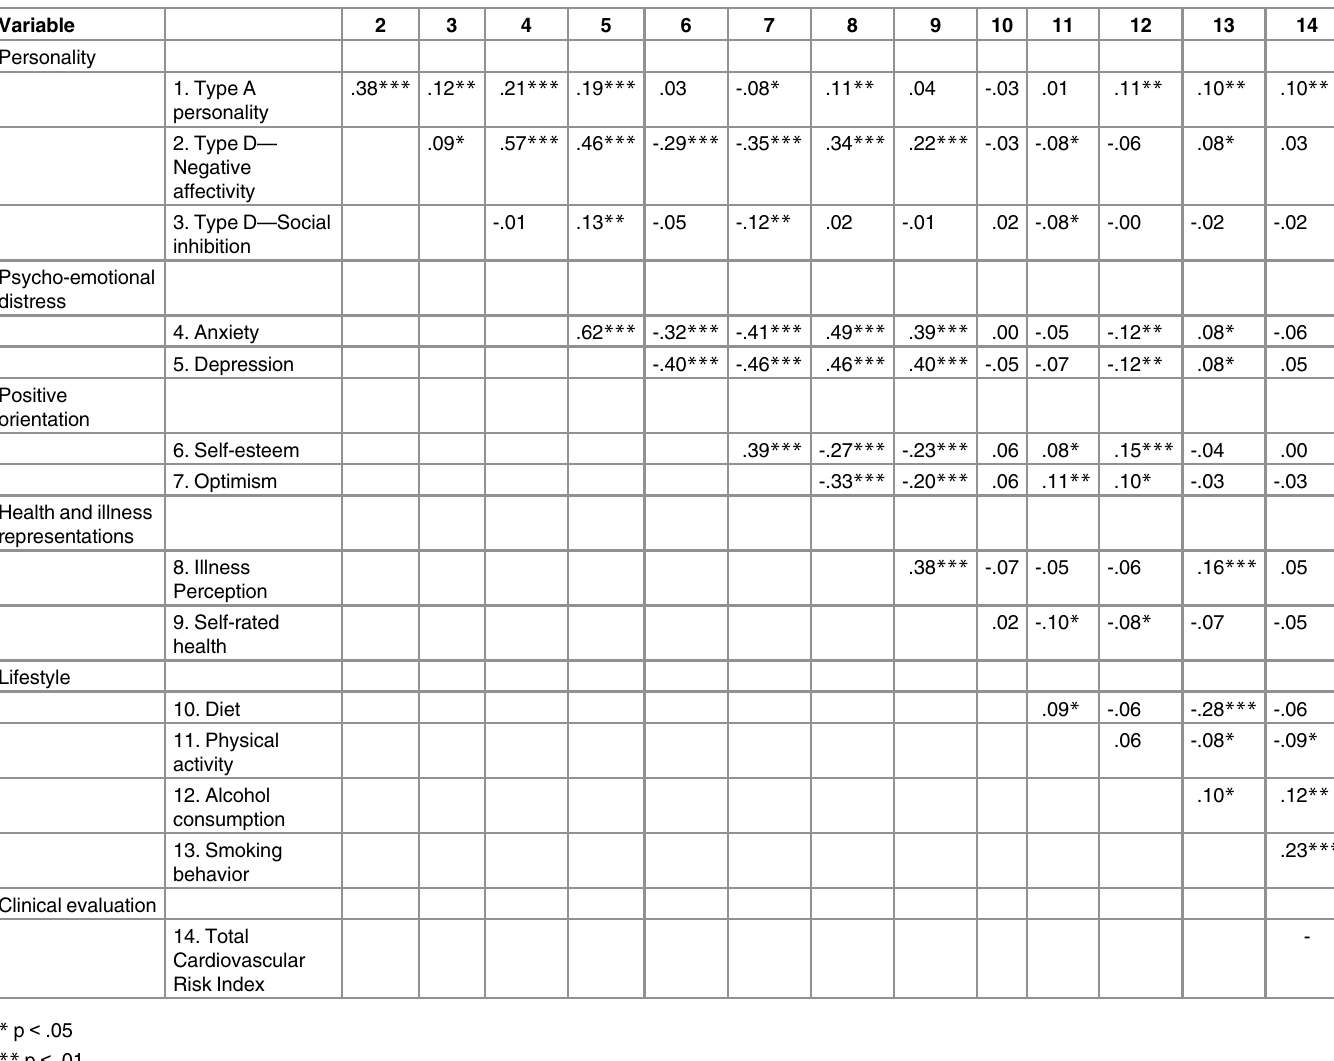
Table 2. Correlations among study